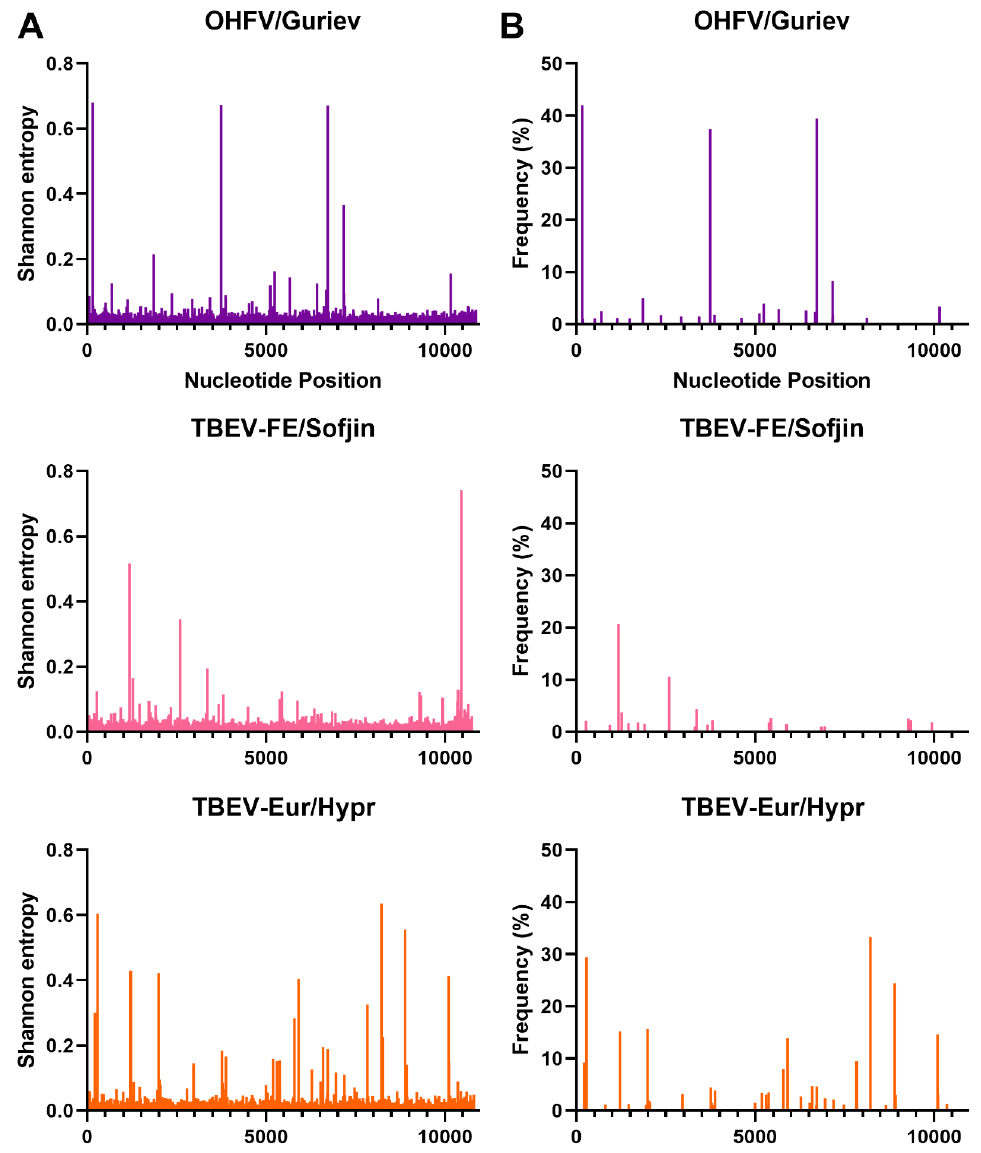
Figure 4. Shannon entropy ( A ) and SNVs ( B ) for OHF, TBE-FE, and TBE-Eur viruses. See Table 1 for details of each sample and virus sample code.